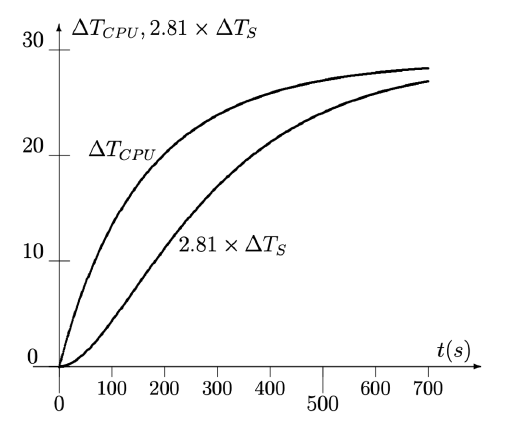
Figure 4. CPU and sensor temperature versus